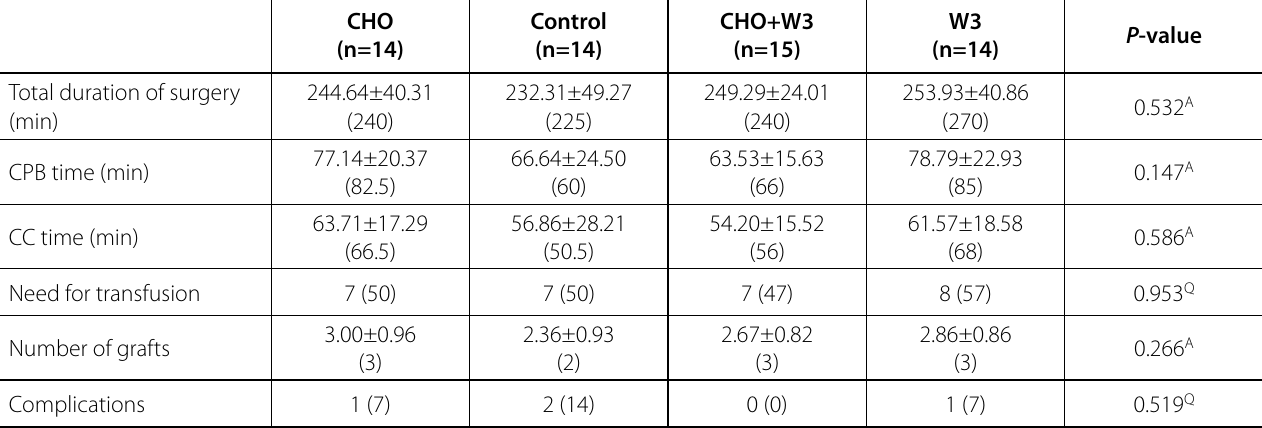
Table 3. Intraoperative clinical data in 57 patients undergoing CABG with CPB.